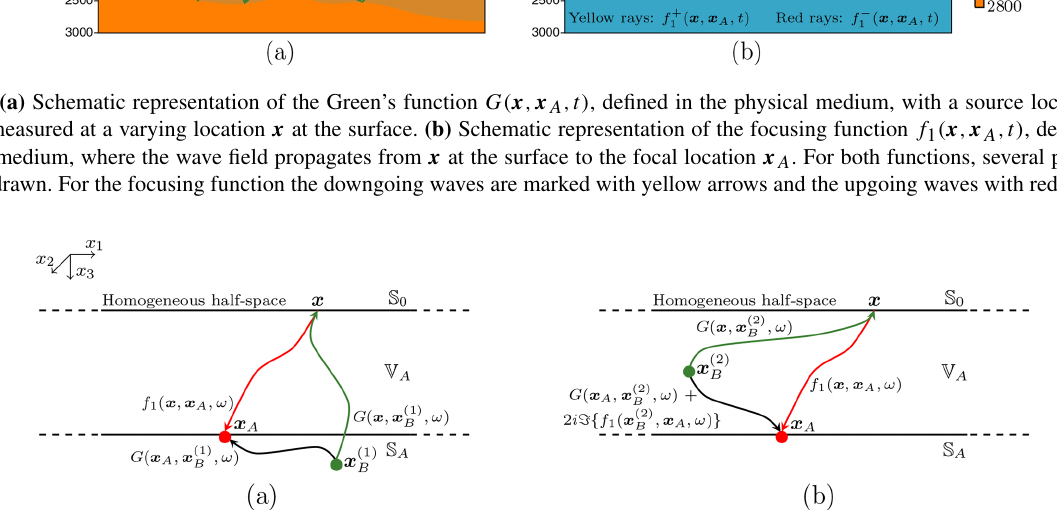
Figure 2. Setup for the single-sided Green’s function representation for (a) a case in which the source of the Green’s function is located below the focal location and (b) a case in which the source of the Green’s function is located above the focal location. The rays in this figure indicate full Green’s functions and focusing functions, including multiple